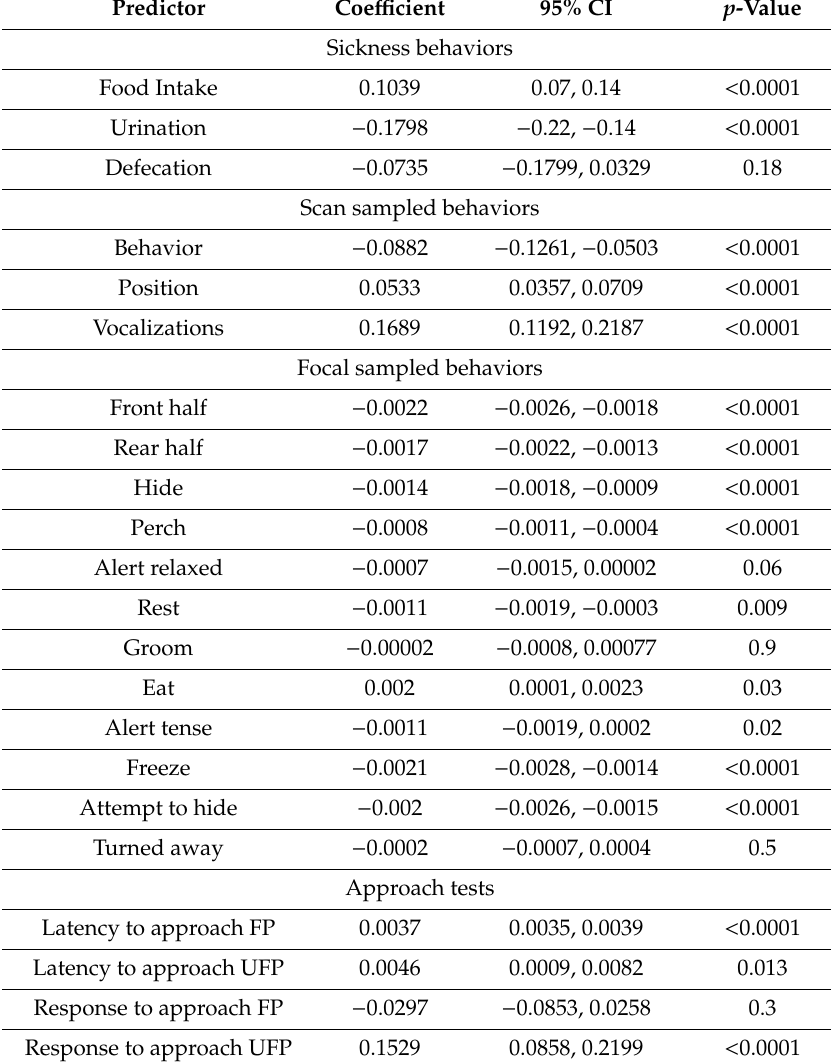
Table 4. Results of a mixed e ff ects generalized linear model ( n = 55). FP familiar person; UFP unfamiliar